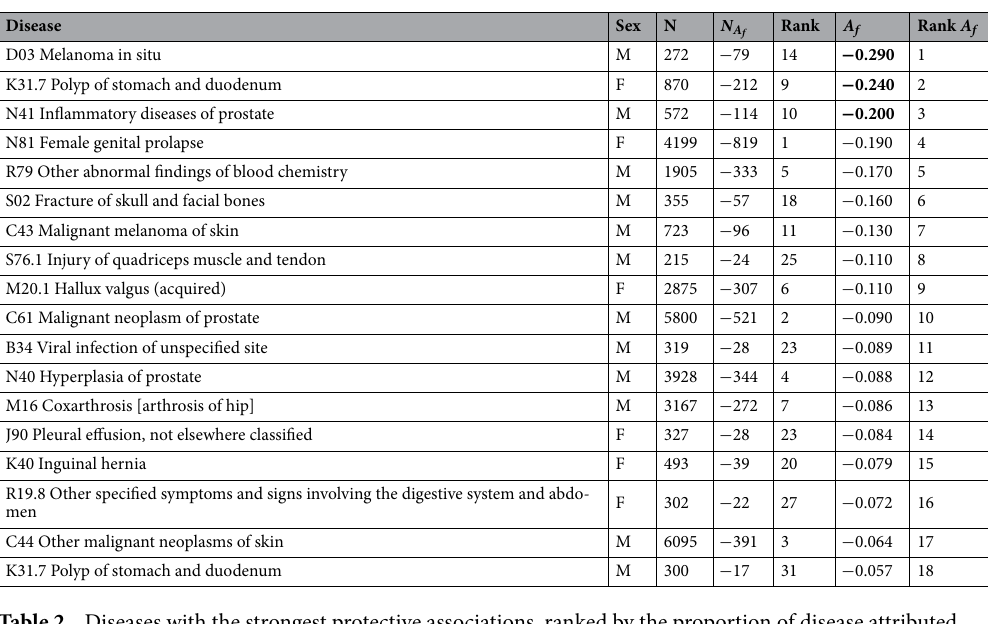
Table 2. Diseases with the strongest protective associations, ranked by the proportion of disease attributed to a combination of smoking and BMI ( A f ), with A f < − 0.2 in bold. Sex indicates diseases in males (M) or females (F), N are total cases, N A are the number of cases attributed to smoking and BMI, A f is the attributable f fraction.